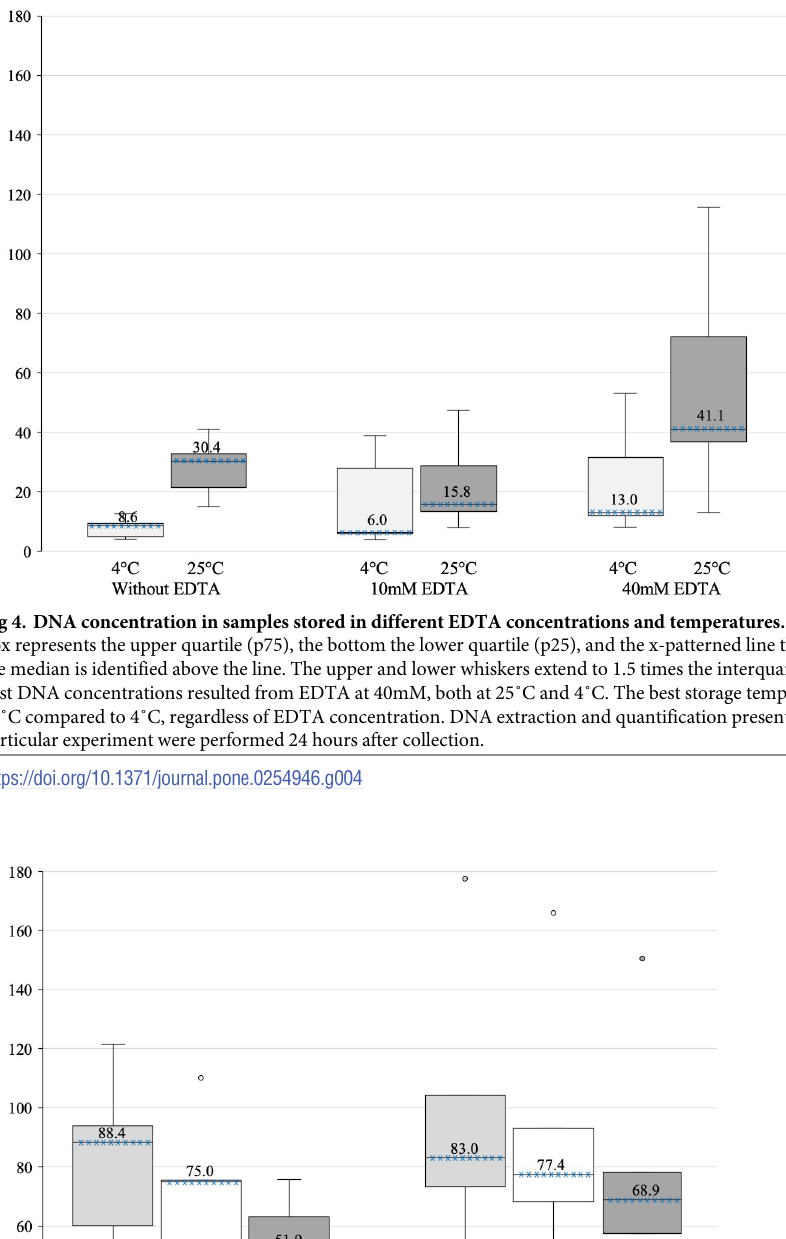
PLOS ONE | https://doi.org/10.1371/journal.pone.0254946 July 21,